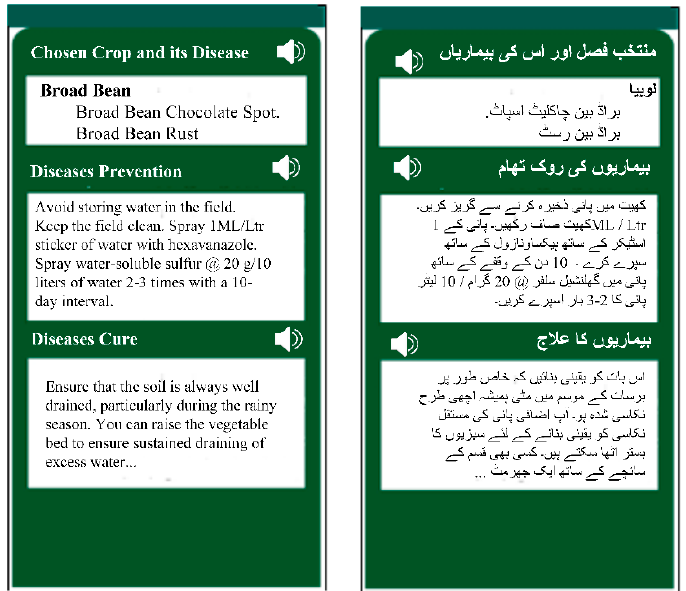
Figure 8. Crops’ Disease Prevention and